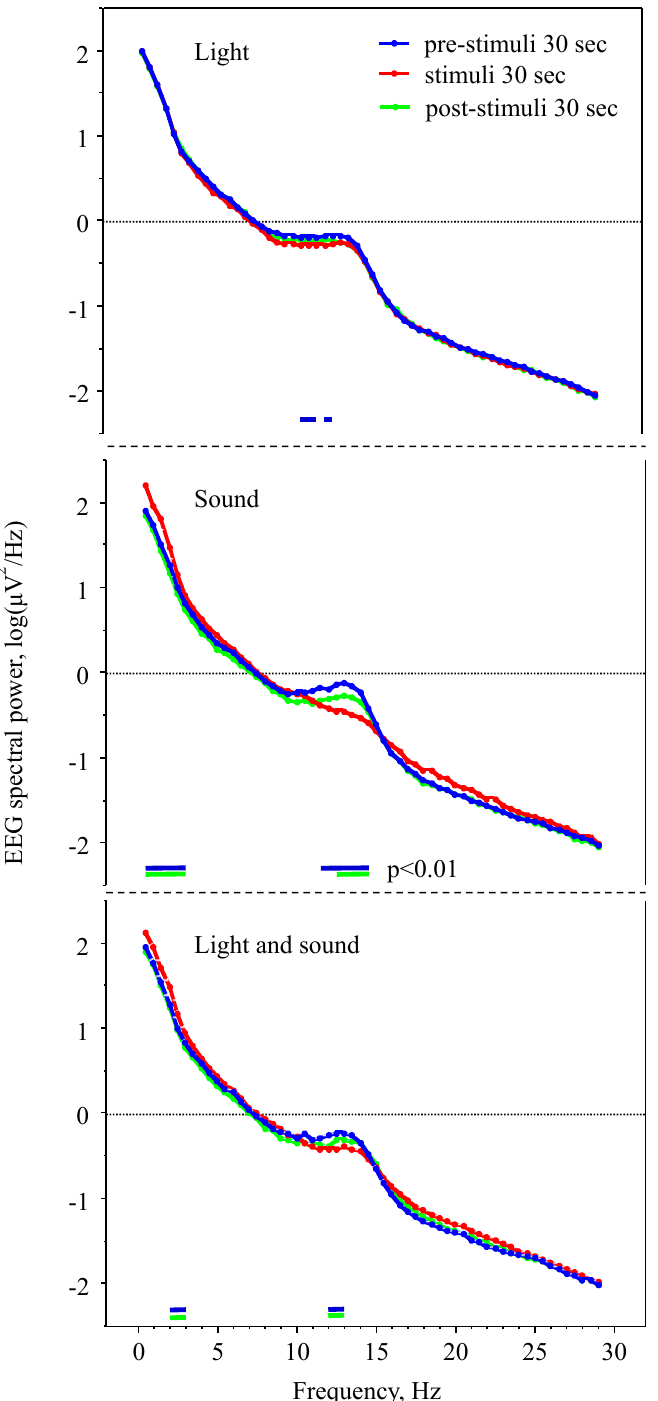
Figure 2. E ff ect of visual and / or acoustic stimulation on EEG spectral power density during sleep stage N3 in 9 healthy subjects. Significant di ff erences ( p < 0.01, Student’s t -test) are indicated by short lines beneath each diagram (blue line: stimuli vs. pre-stimuli epochs, green line: stimuli vs. post-stimuli